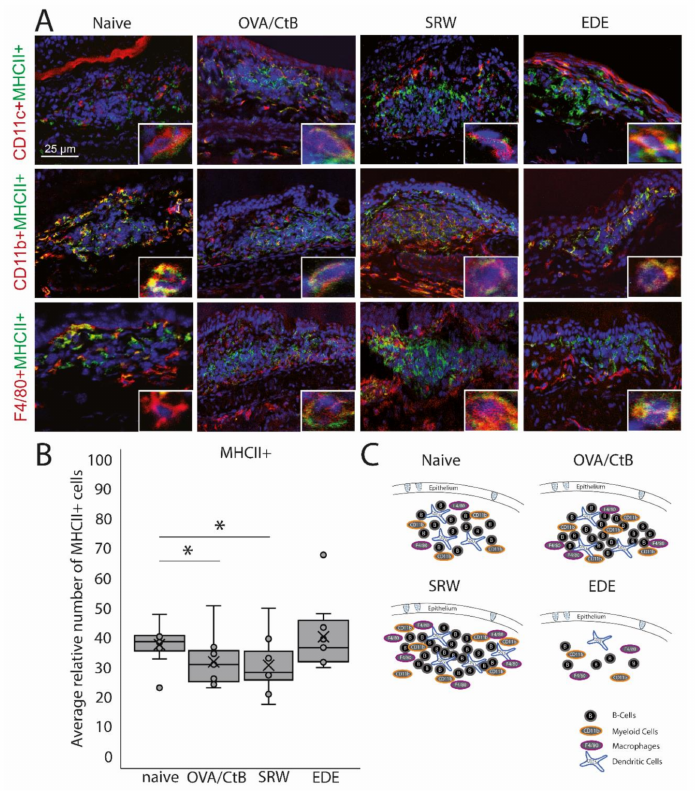
Figure 2. Antigen-presenting cells within CALT. ( A ) Immunohistochemistry of